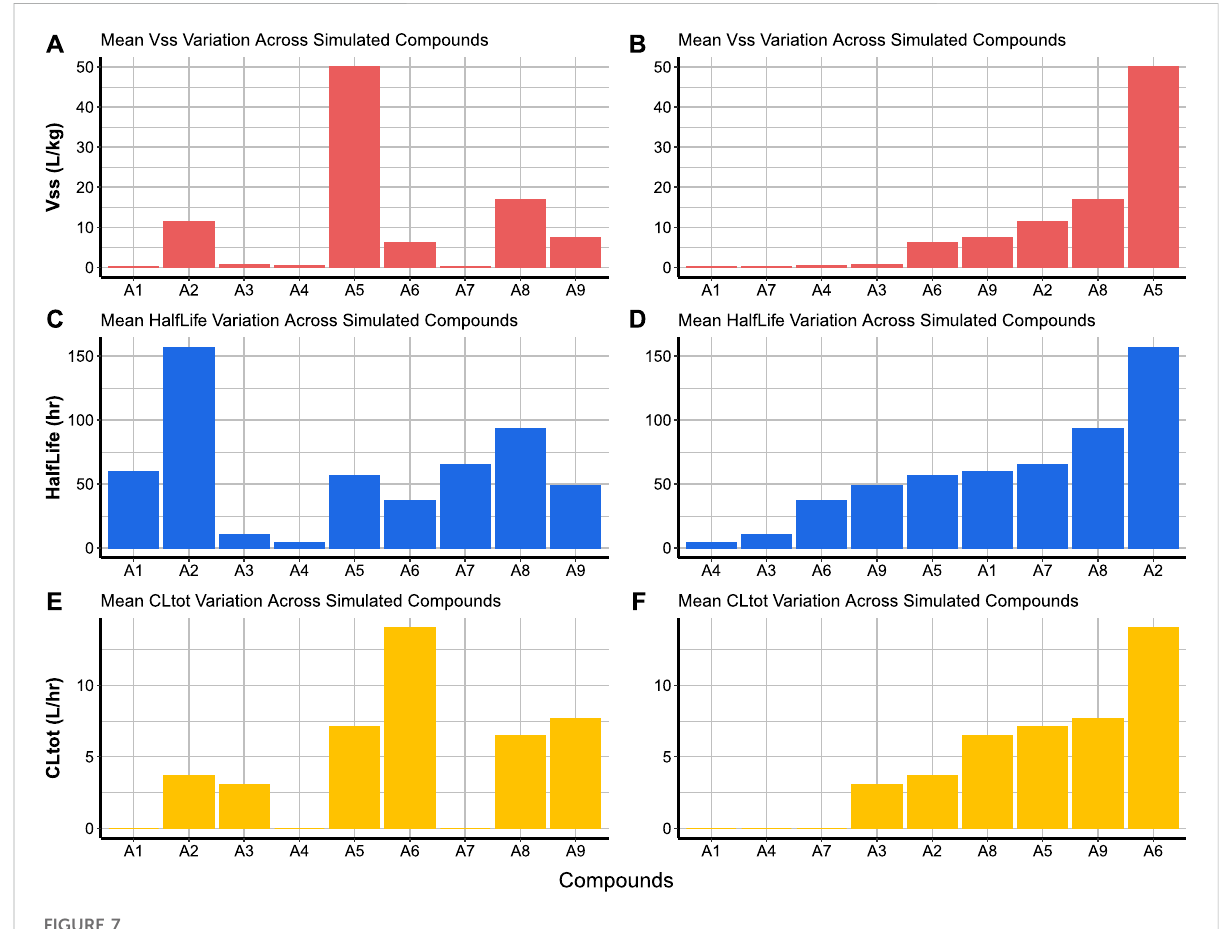
FIGURE 7 Cross-compound comparison charts allow the visualisation of different parameter means for each compound across the simulated populations. The bars can be organised in the alphanumeric order of compound codes as in panels (A) , (C) , and (E) , or in ascending order of parameter values as in panels (B) , (D) , and (F)